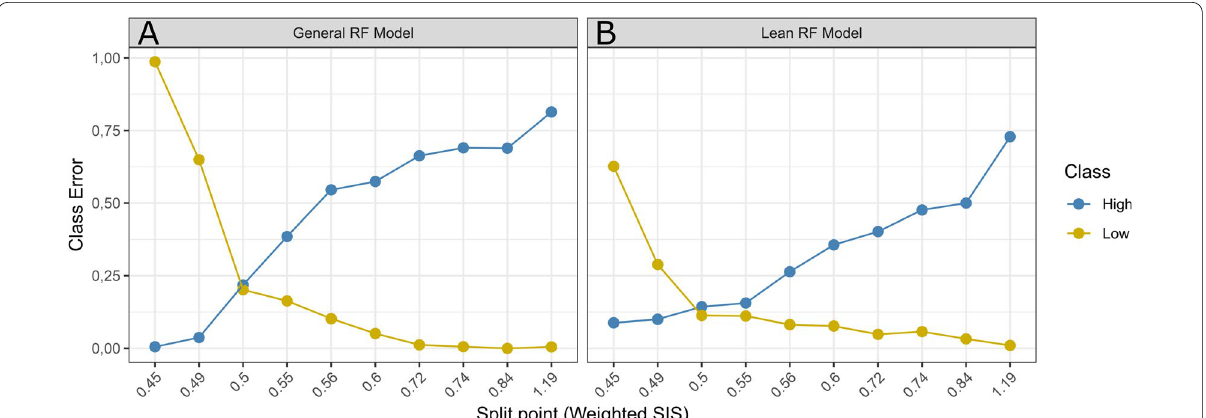
Fig. 3 Scatter plot of class errors correspond to General ( A ) and Lean ( B ) random forest (RF) models with a different composition of “High” and “Low” shedding groups. General RF model built with all ASVs passed quality control and Lean RF model employed only AVS significantly contributing to classification. On the x-axis Weighted Shedding Intensity Scores (SISs) are shown that were used as a split point for the groups division, and y-axis depict the class error expressed in